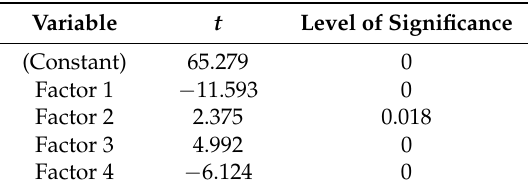
Table 1. Significance levels for factors in regression.